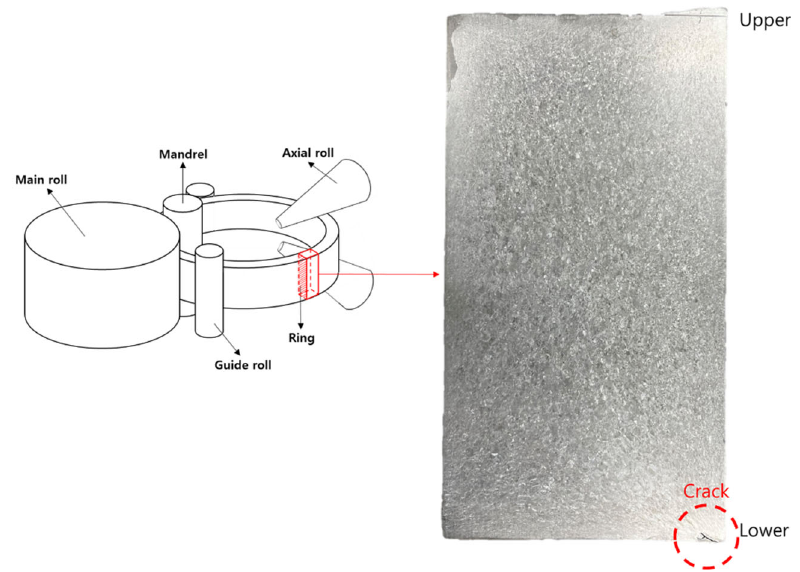
Figure 16. Macrostructure after ring-rolling process of Ti-6Al-4V alloy at 1050 ◦ C, 1 × 10 − 2